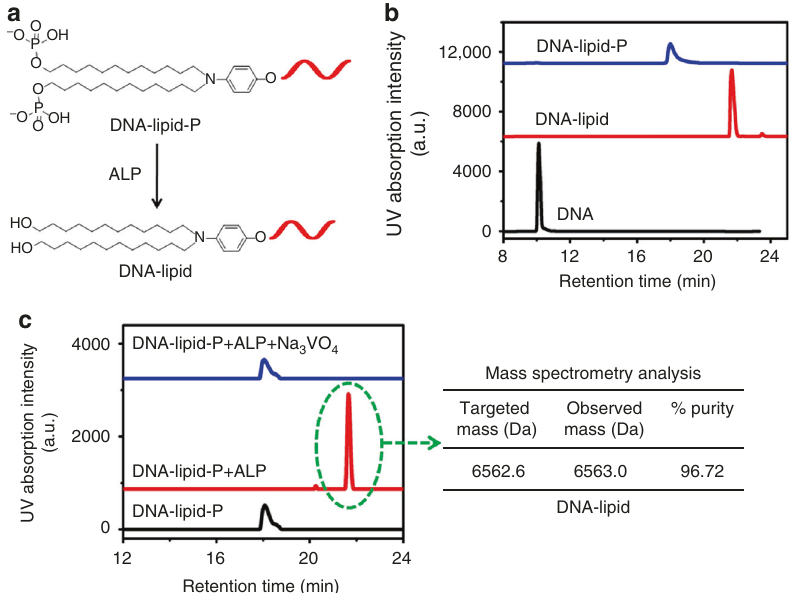
Fig. 4 Enzymatic dephosphorylation of DNA-lipid-P. a Schematic illustration of ALP-induced dephosphorylation of DNA-lipid-P. b HPLC chromatograms of DNA, DNA-lipid and DNA-lipid-P. c Left: HPLC chromatograms of DNA-lipid-P in buffer solution (black line), DNA-lipid-P treated with ALP (0.5 U mL − 1 ) in buffer solution (red line) and DNA-lipid-P treated with ALP (0.5 U mL − 1 ) in buffer solution containing 2 mM Na 3 VO 4 (blue line). Right: mass spectrometry analysis of DNA-lipid-P after treatment with ALP (0.5 U mL − 1